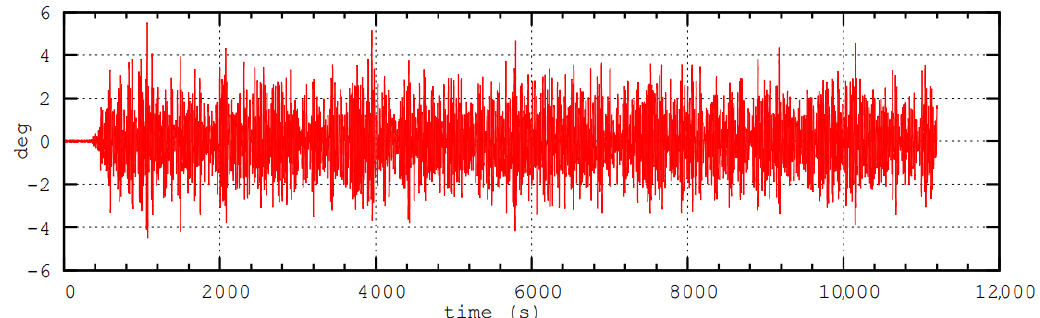
Figure 12. Pitch response to IW8 according to experiments.